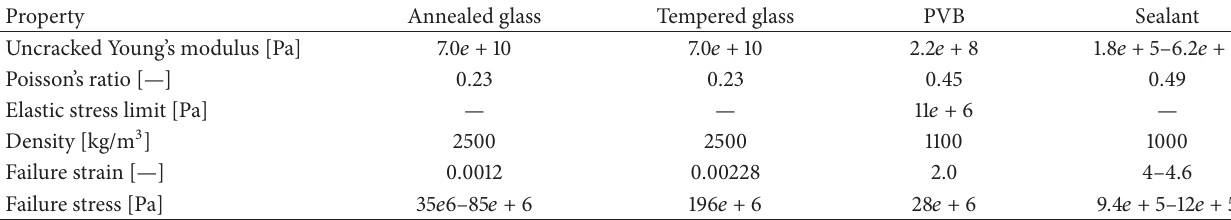
Table 2: Typical material properties for glass, PVB, and